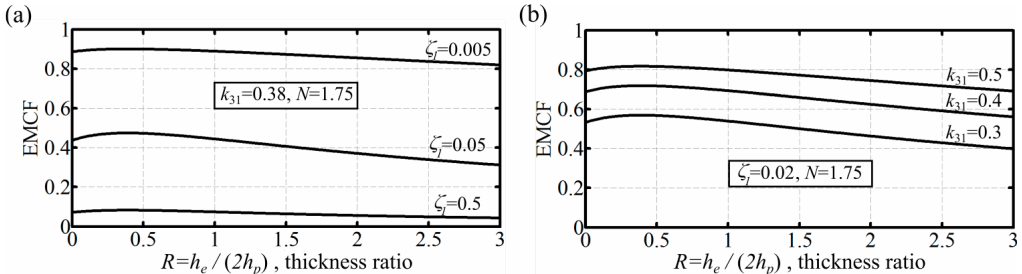
Figure 4. Triple layer bimorph dynamic EMCF as function of (passive/active) layer thickness ratio for a passive layer with a stiffness ratio of 1.75. ( a ) effect of damping ratio; k 31 = 0.38; ( b ) effect of the PZT layer transverse electromechanical coupling coefficient; ζ 1 = 0.02.